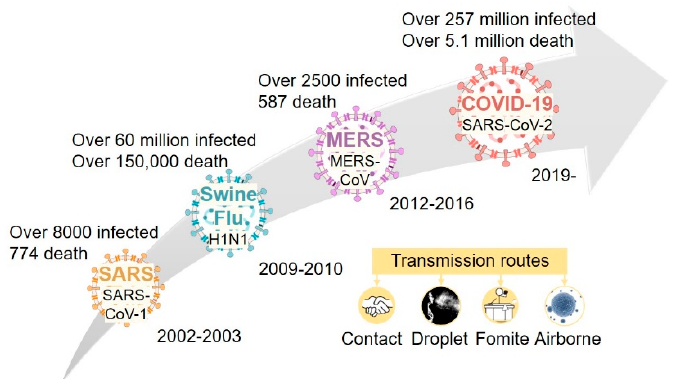
Figure 1. Emerging novel respiratory infectious diseases over the last two decades.